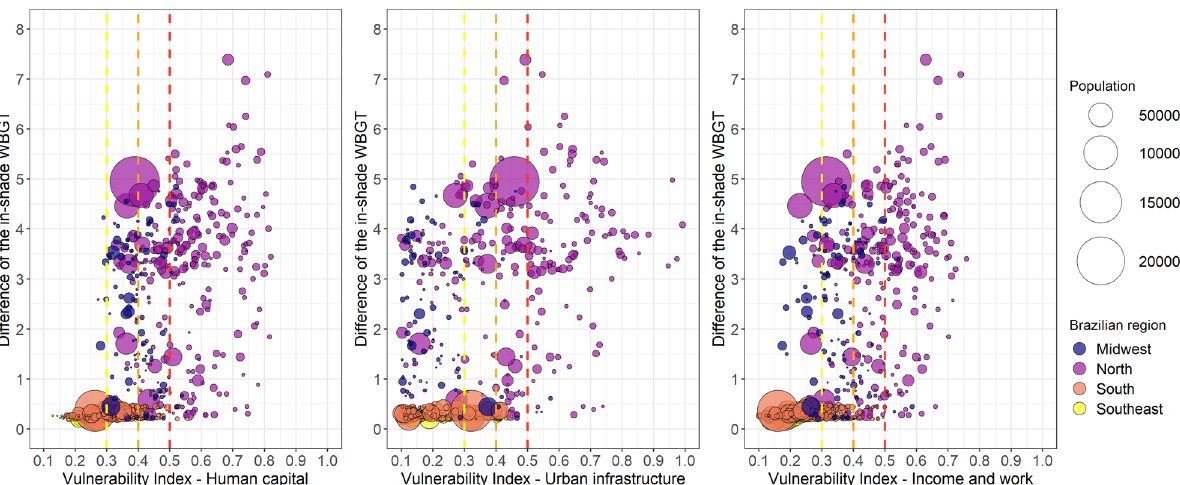
Fig. 4 Municipalities impacted by Amazon savannization RCP8.5 global warming scenario (2073 – 2100). Municipalities impacted by Amazon savannization RCP8.5 global warming scenario (2073 – 2100), according to the social vulnerability index (SVI) components. Legend: The impacted municipalities were de fi ned as those with a difference between the average daily maximum of the in-shade WBGT in the hottest month (85S – 85F scenarios) higher than 0.2. The SVI was classi fi ed: 0.3 – 0.4: moderate vulnerability (dashed yellow line); 0.4 – 0.5: high vulnerability (dashed orange line); greater than 0.5: very high vulnerability (dashed red line). The impacted population comprised 29,648,362 people, of which 42% reside in the northern region, 35% in the southern region, 16% in the southeastern region, and 7% in the midwestern